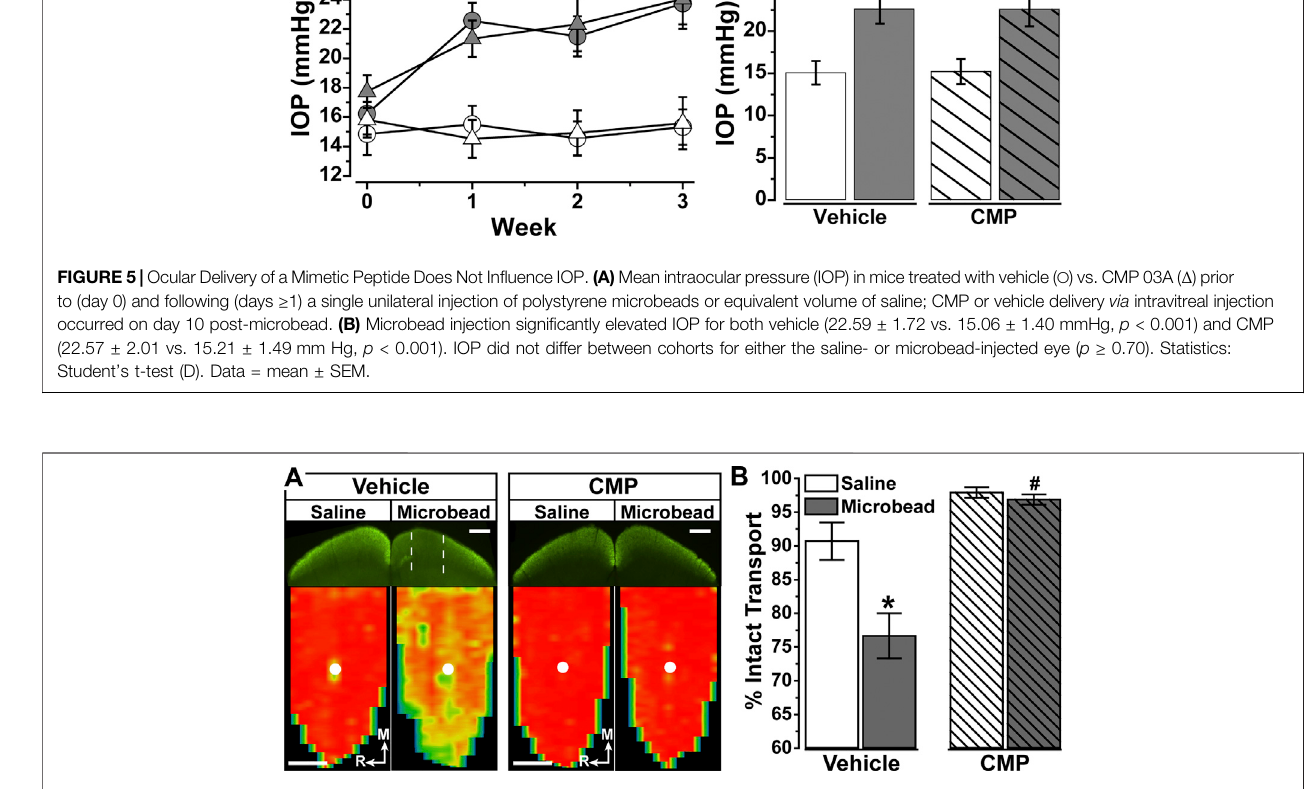
Frontiers in Pharmacology |